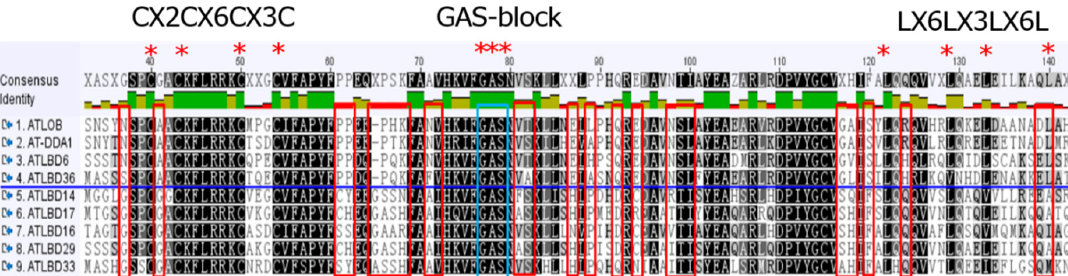
Figure 5. Sequence comparison of selected Class IA and Class IB LBD proteins. Red frame indicates conserved amino acid residue within each clade. “*” indicates conserved amino acid residues across different clades.